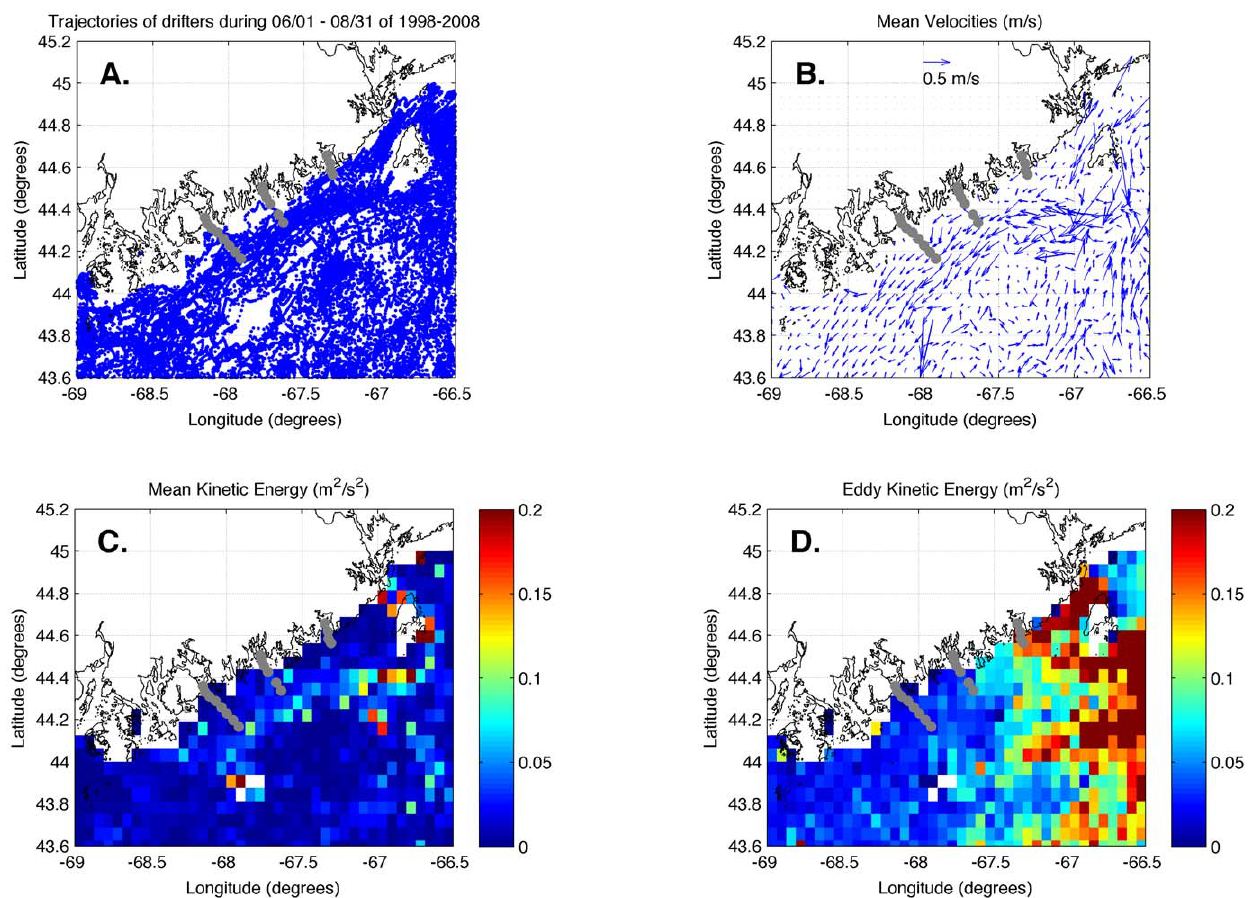
Figure 9. Trajectories (A) and analysis (B, C, D) of surface and drogued drifter data. The three analysis panels present mean velocities (B), mean kinetic energy (C), and eddy kinetic energy (D) calculated from drifters entering the study region from June 1 – August 31 of 1998–2009. Gray circles indicate CTD and larval sampling stations.